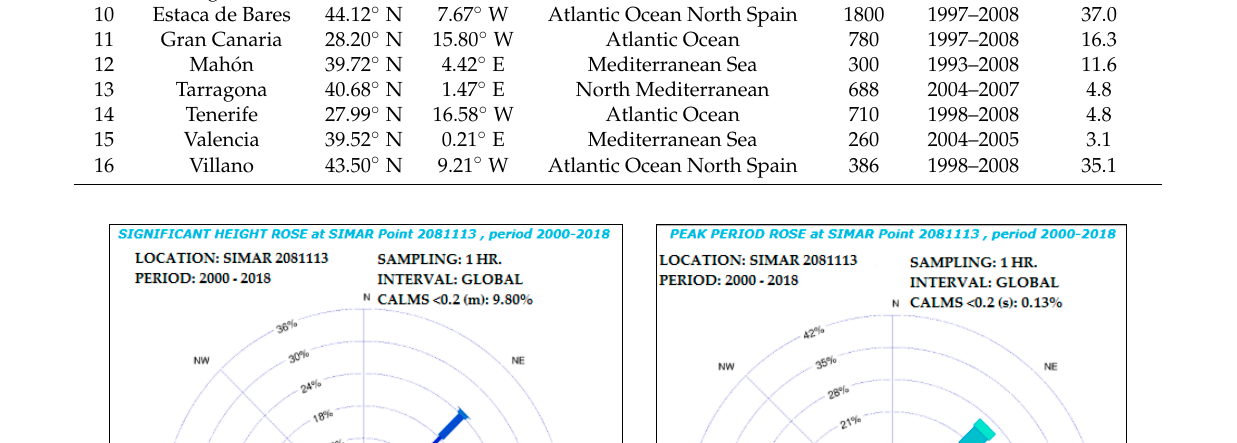
Figure 10. ( a ) REDEXT buoys according to Table 6. ( b ) Location of Valencia Buoy, SIMAR 2081113 and SIMAR 622028053 points. Source: www.puertos.es.